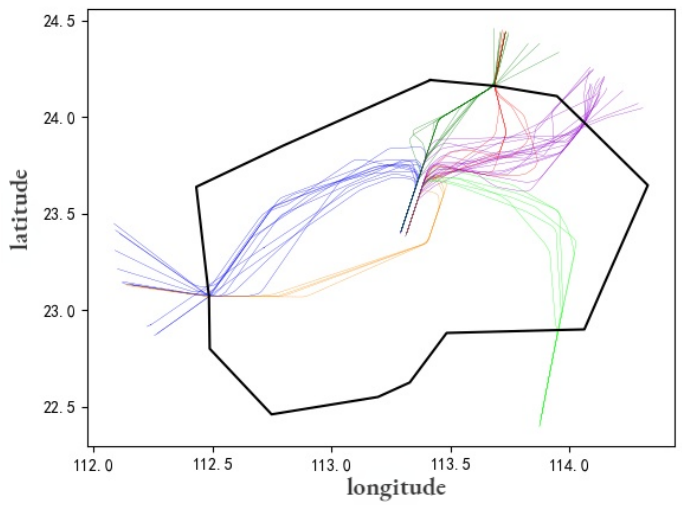
Figure 8. The distribution of ADS-B tracks of inbound flights in the terminal area of Guangzhou Baiyun Airport